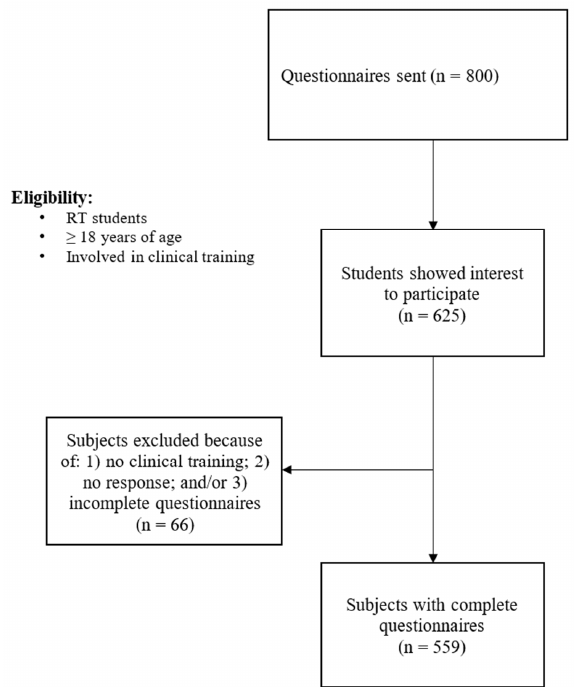
Figure 1. Flow chart of the study. Table 1. Demographic data of study participants (n = 559).